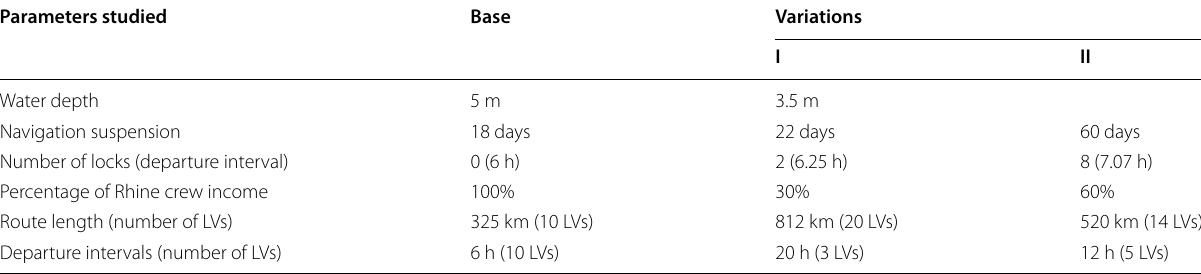
Table 7 Sensitivity analysis input data Parameters